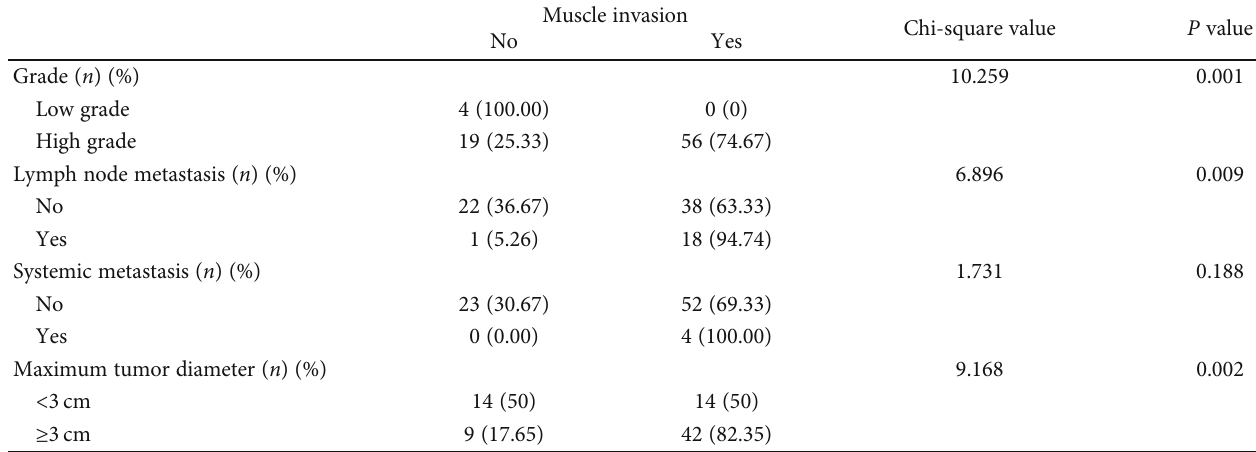
Table 3: The association between pathological stage and grade.